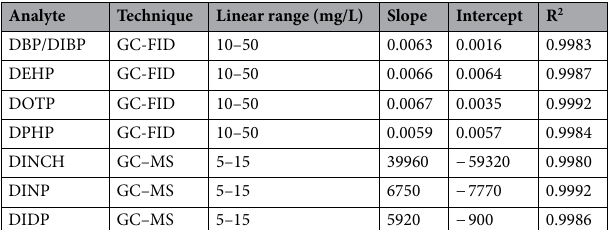
Table 2. Parameters of the least-square regression equation of DBP, DEHP, DOTP, DPHP, DINCH, DINP and DIDP.